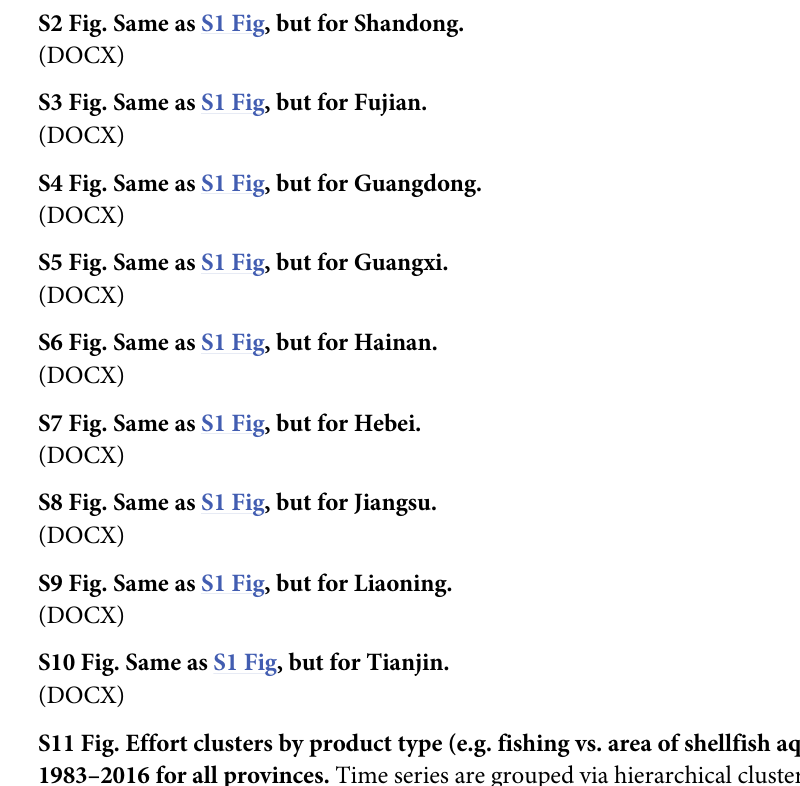
S4 Fig. Same as S1 Fig, but for Guangdong. S5 Fig. Same as S1 Fig, but for Guangxi. S6 Fig. Same as S1 Fig, but for Hainan. S7 Fig. Same as S1 Fig, but for Hebei. S8 Fig. Same as S1 Fig, but for Jiangsu. S9 Fig. Same as S1 Fig, but for Liaoning. S10 Fig. Same as S1 Fig, but for Tianjin. S11 Fig. Effort clusters by product type (e.g. fishing vs. area of shellfish aquaculture)